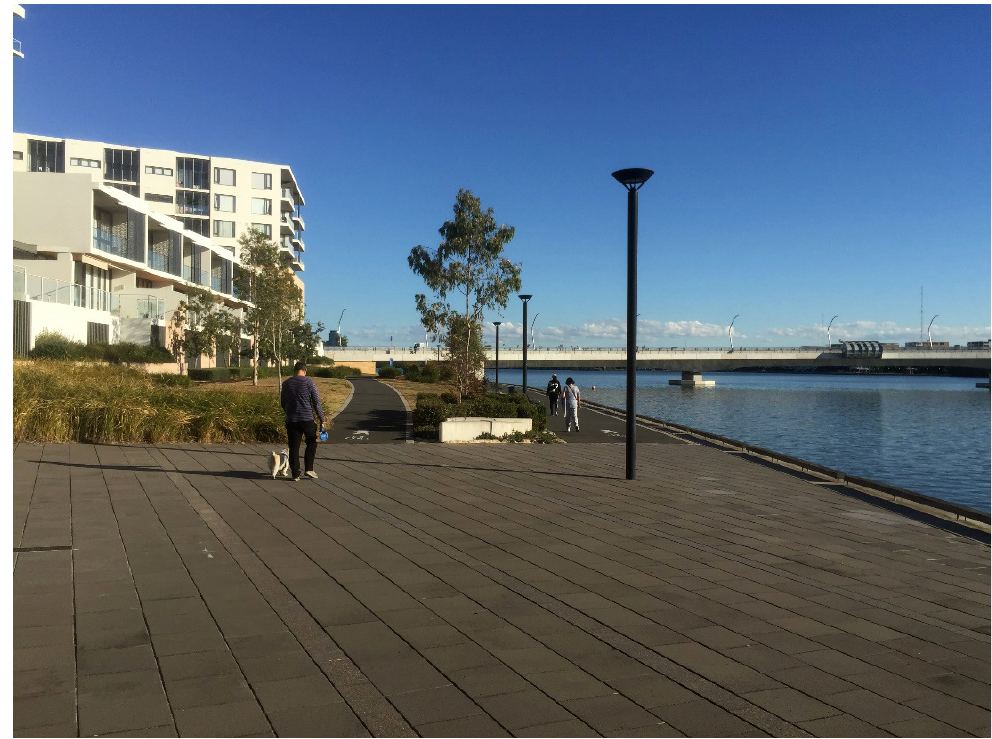
Figure 3. Rhodes foreshore, looking south across Homebush